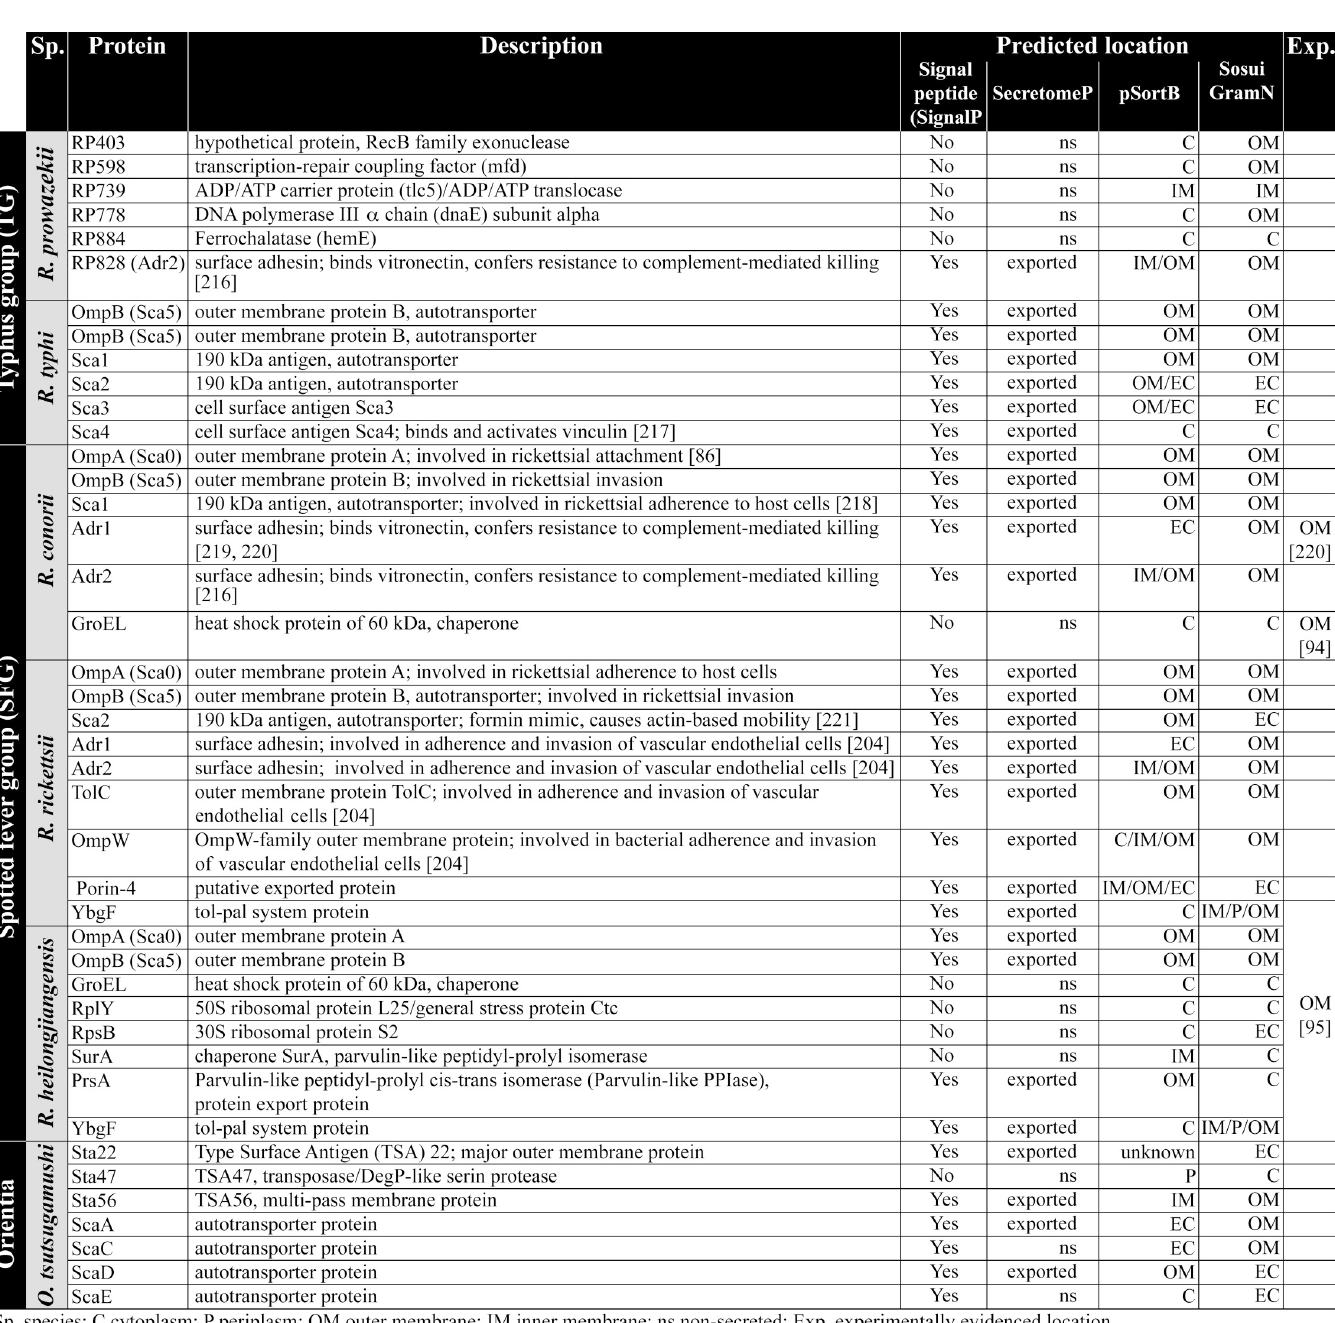
strategies mentioned so far are time consuming and expensive and not suitable for large-scale vaccine production. Therefore, it is still an effort to identify antigenic proteins and peptides